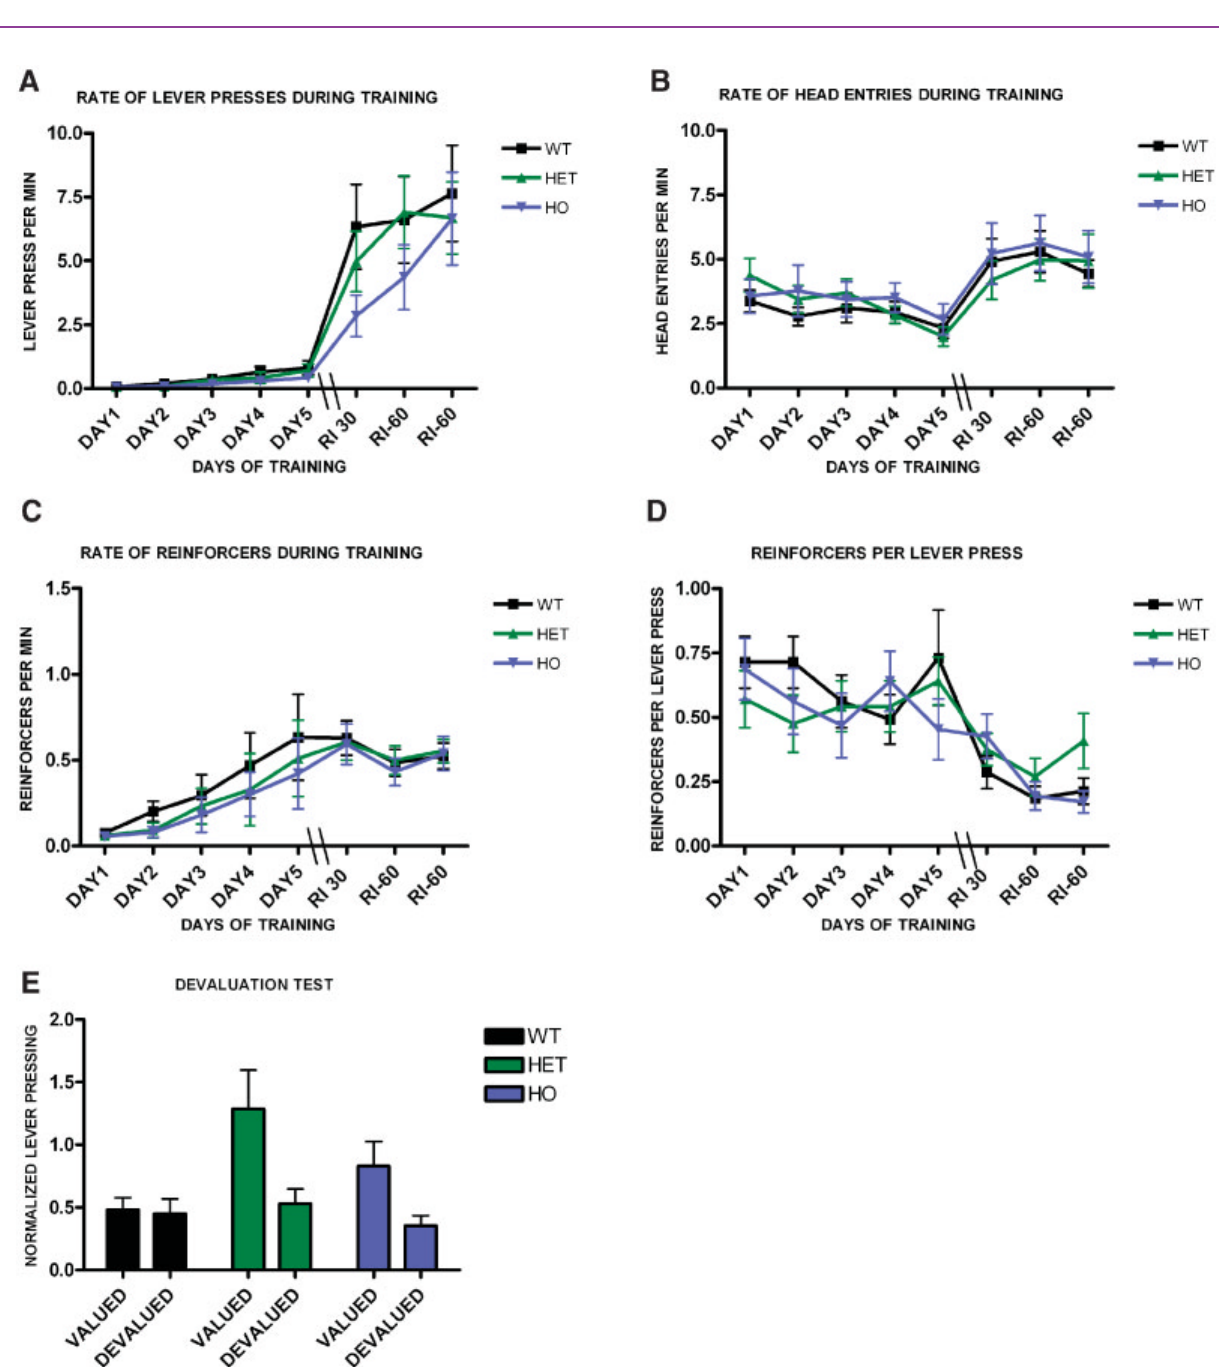
Figure 5. Decreased predisposition for habit formation in CB1 mutant mice. ( A ) Acquisition of the lever pressing task in WT, CB1 +/ − , and CB1 − / − mice trained in a random interval schedule. The rate of lever pressing (per minute) for each daily session is depicted. ( B ) Average rate of head entry throughout training for the WT, CB1 +/ − , and CB1 − / − mice. ( C ) Average rate of reinforcement throughout training for WT, CB1 +/ − , and CB − / − mice. ( D ) Rate of reinforcement per lever press throughout training for WT, CB +/ − , and CB1 − / − mice. ( E ) Normalized lever pressing during the valued versus the devalued condition for WT, CB +/ − , and CB1 − / −